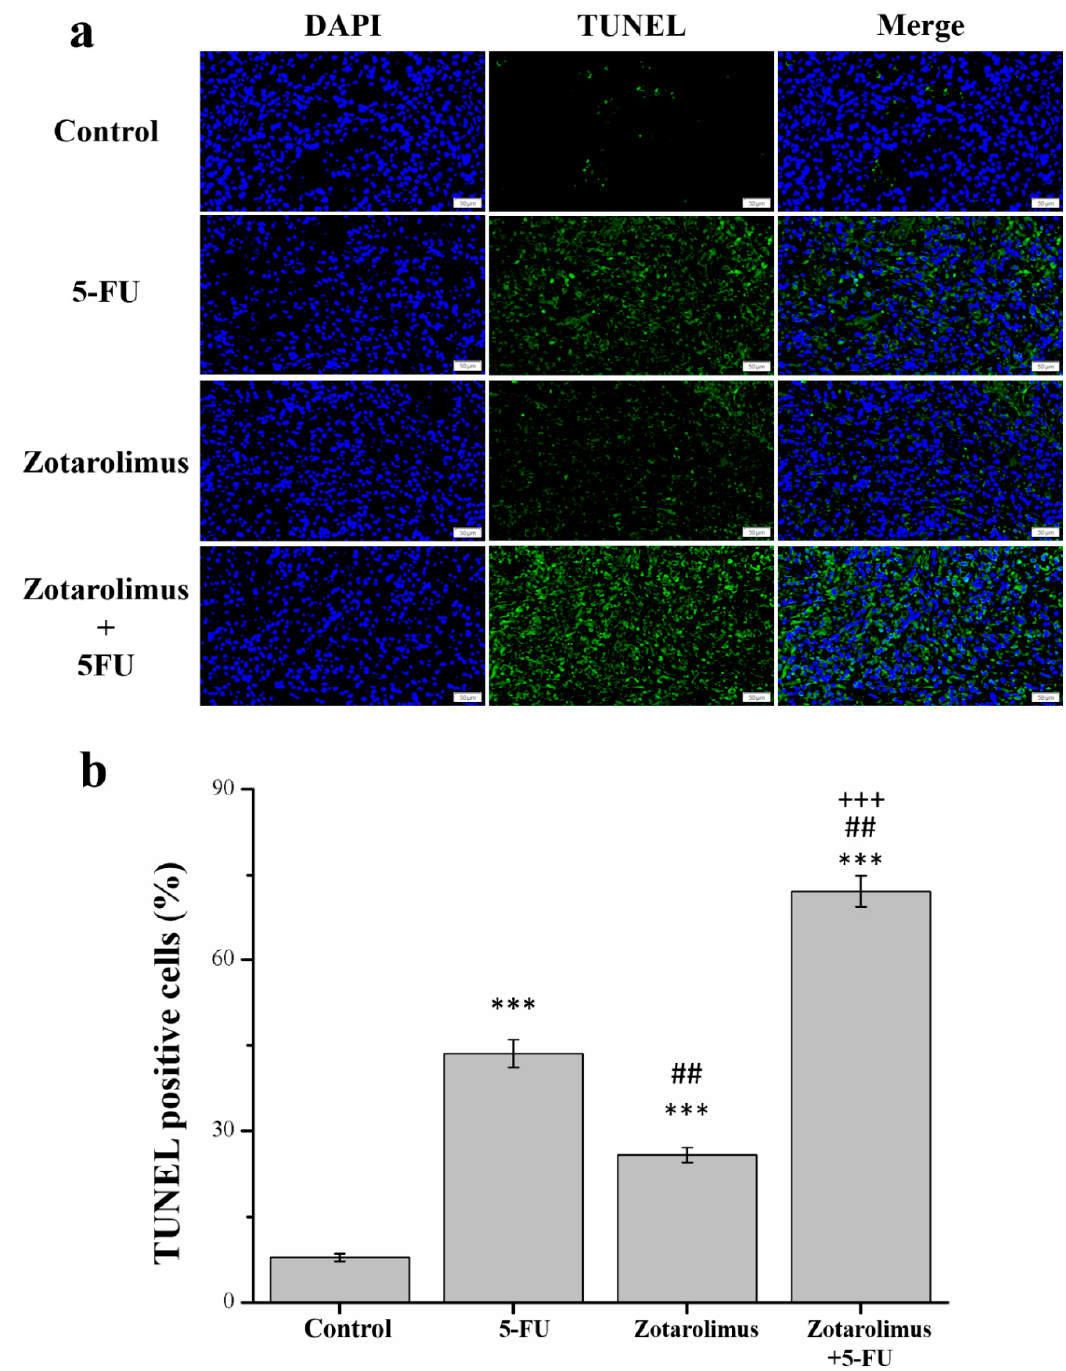
Figure 2. Analysis of apoptosis in A549 tumors by TUNEL/DAPI staining ( × 200). ( a ) Images of TUNEL and DAPI staining and merge. ( b ) The percentage of TUNEL positive cells in the A549 tumor mass of control BALB/cByJNarl mice and mice given different treatments: 5-FU (100 mg/kg/week), zotarolimus (2 mg/kg/day), and zotarolimus (2 mg/kg/day) combined with 5-FU (100 mg/kg/week). All data are presented as mean ± standard deviation, n = 7 per group. *** p < 0.001 compared with the control group. ## p < 0.01 compared with the 5-FU-treated group. +++ p < 0.001 compared with the zotarolimus-treated group. All treatments were started on day 7 when tumors were detected. Scale bars = 50 µm.